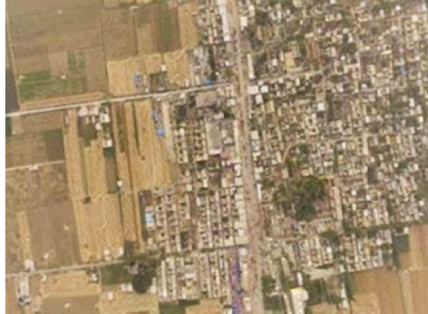
Figure 21: High-resolution surveying and mapping maps with a 1: 500